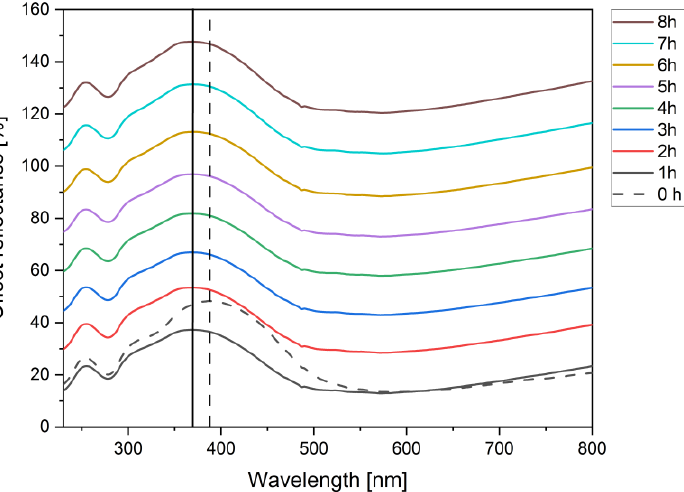
Figure 2. Normal incidence reflectance spectra of a blue Polyommatus icarus wing in air after 72 h of immersion in deionized water (dashed curve) and during the following eight hours. The spectra of the drying wing taken at one-hour intervals were offset vertically to enhance clarity. After the first hour of drying, no significant changes occurred.